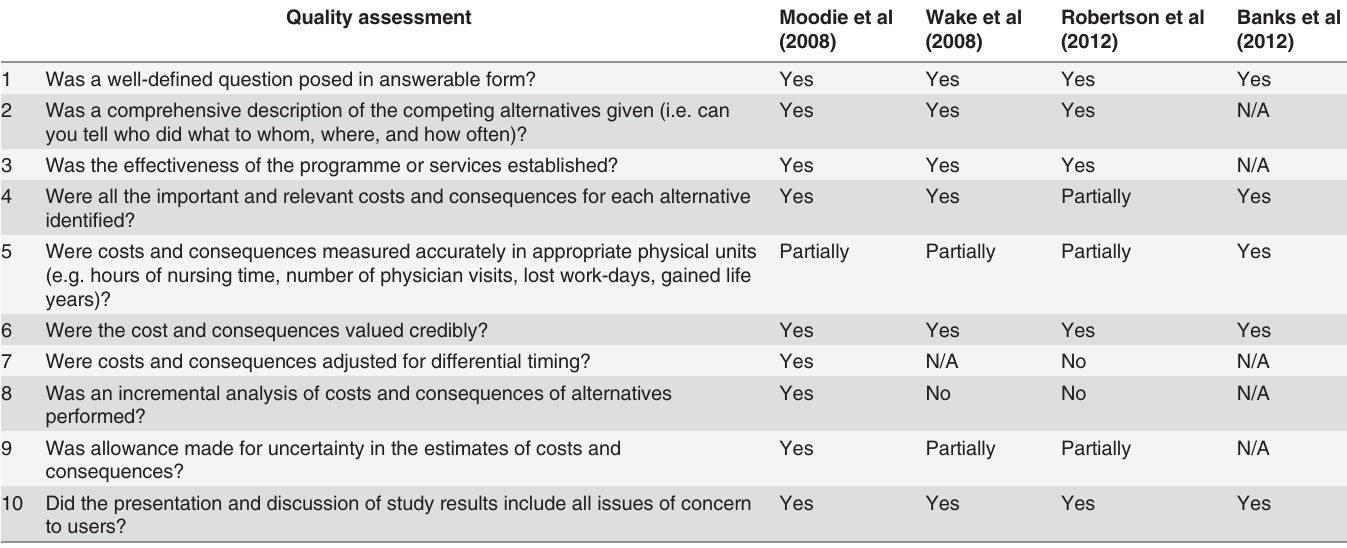
Table 2. Quality assessment of included studies based on Drummond et al